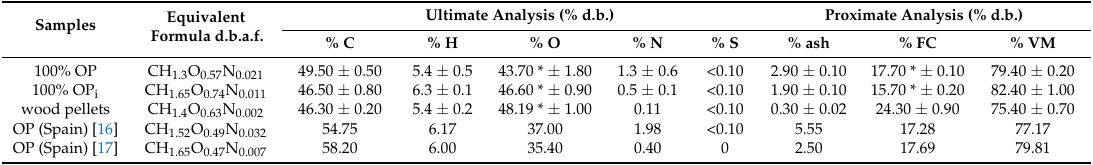
Table 4. Pellets characteristics.